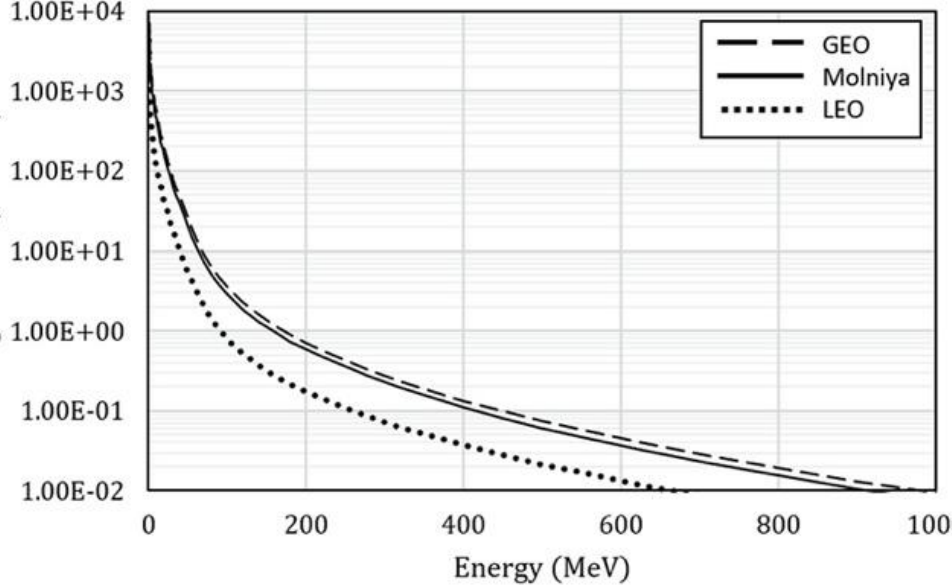
Figure 20. Average integral flux of solar protons in LEO, GEO and Molniya orbit.